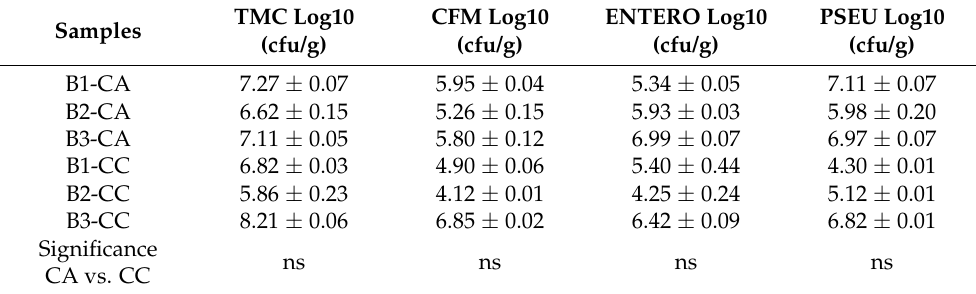
Table 1. Microbiological counts of the natural creaming-derived and centrifuge-derived creams samples. Data are expressed as mean values ± standard deviation (n = 3) of each batch.